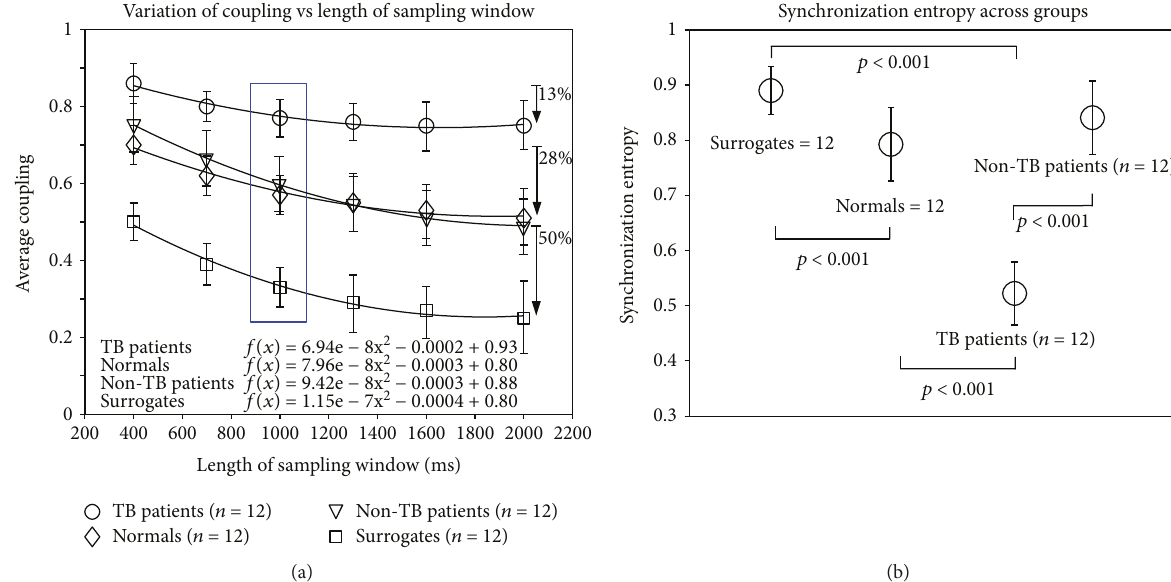
Figure 2: Average APC ± SD values versus length of the analysis window for TB patients, non-TB patients, normals, and surrogate group, respectively. (a) The fi t models represent the rate of loss as a function of the length of the analysis window. The downward arrows indicate the “ loss of coupling ” as percentage of the initial values for each group, respectively. The blue frame includes the standard interval (1000ms) values, where the di ff erences among the four groups were found statistically signi fi cant. In (b), the average synchronization entropy values (SE ± SD) across the four groups are shown. Pairwise comparison of entropy values using the Mann – Whitney rank-sum test shows signi fi cant di ff erences ( p < 0 001 ) in the group pairs: normals-TB patients, normals-surrogates, surrogates-TB patients, and TB patients-non-TB